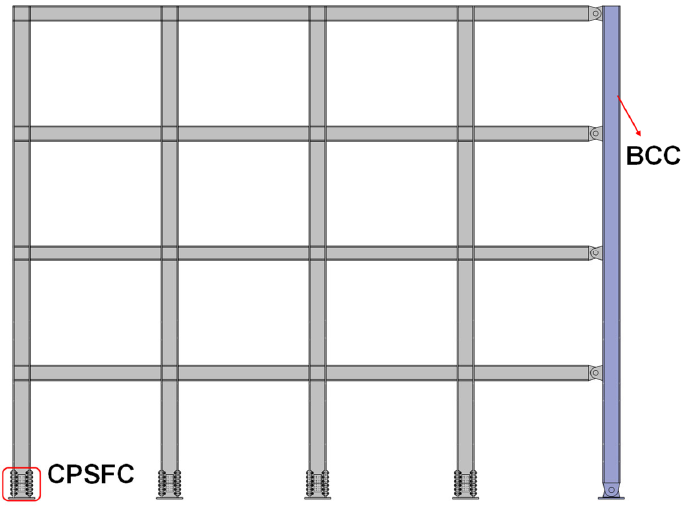
Figure 1. Diagram of the CPSFC–BCCF structural system (BCC is the built ‐ in continuous column).